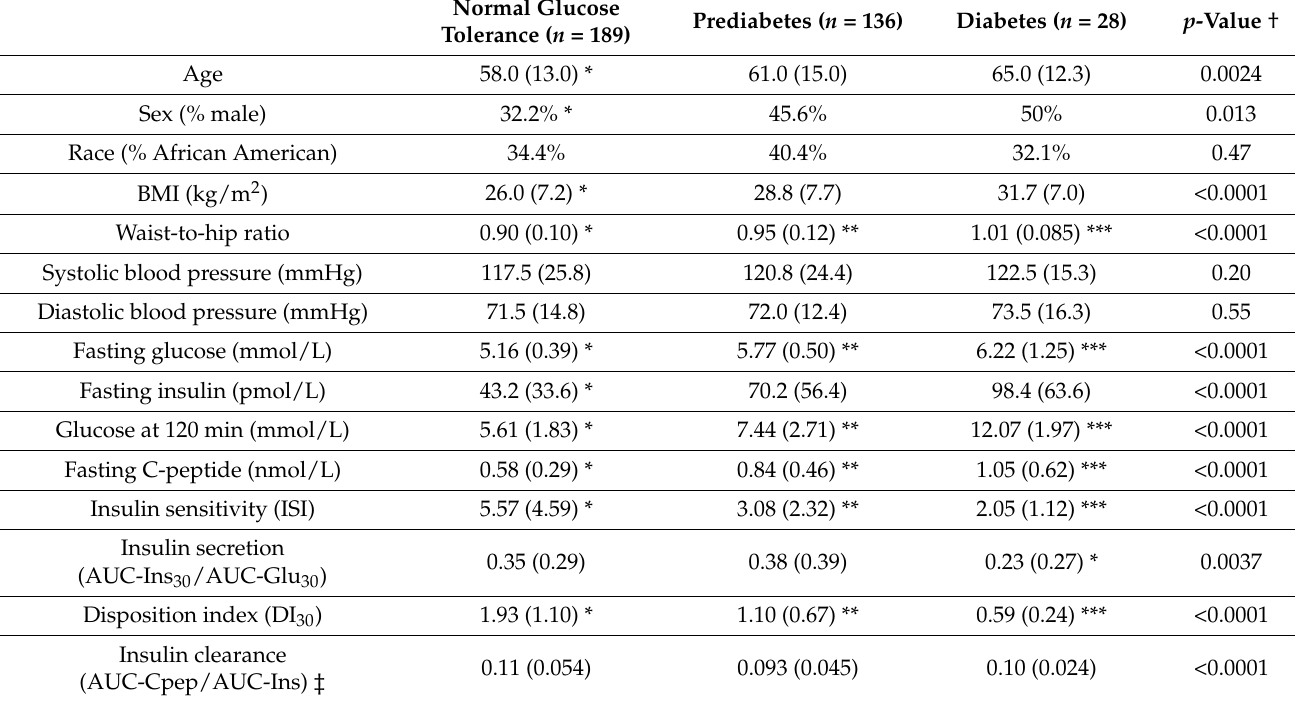
Table 1. Clinical and glucose and insulin homeostasis characteristics by glycemic category.